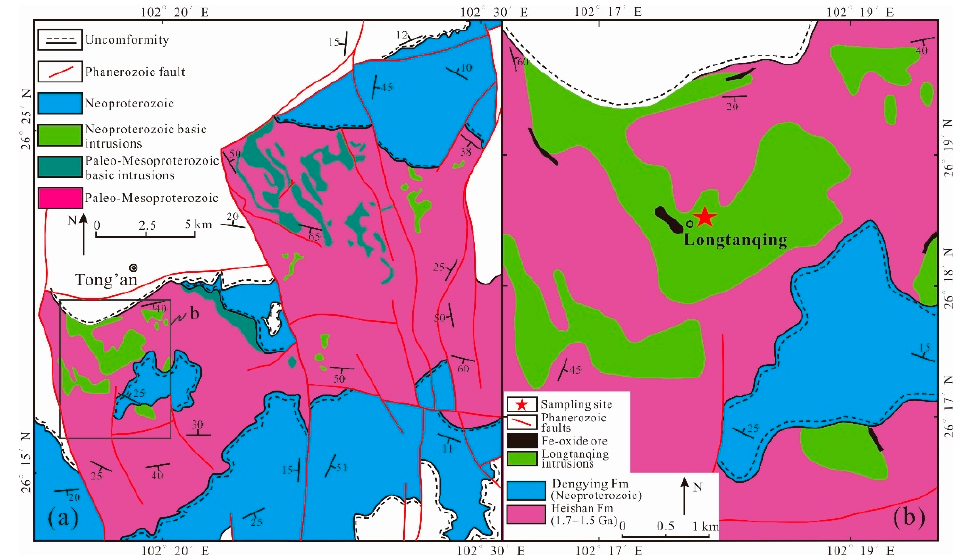
Figure 2. ( a ) Simplified geological map of Mesoproterozoic to Neoproterozoic rocks in the Tong’an region; ( b ) Geological map of the LTQ and sample locations.